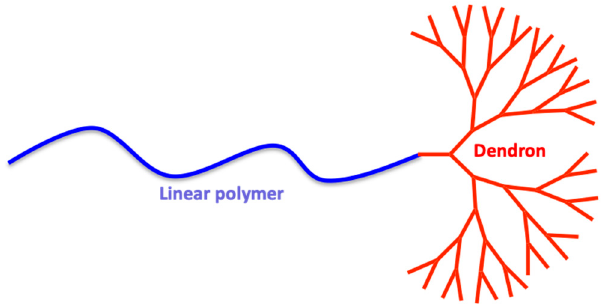
Figure 1. Basic structure of an architectural polymer (telodendrimer): Linear polymer and dendron